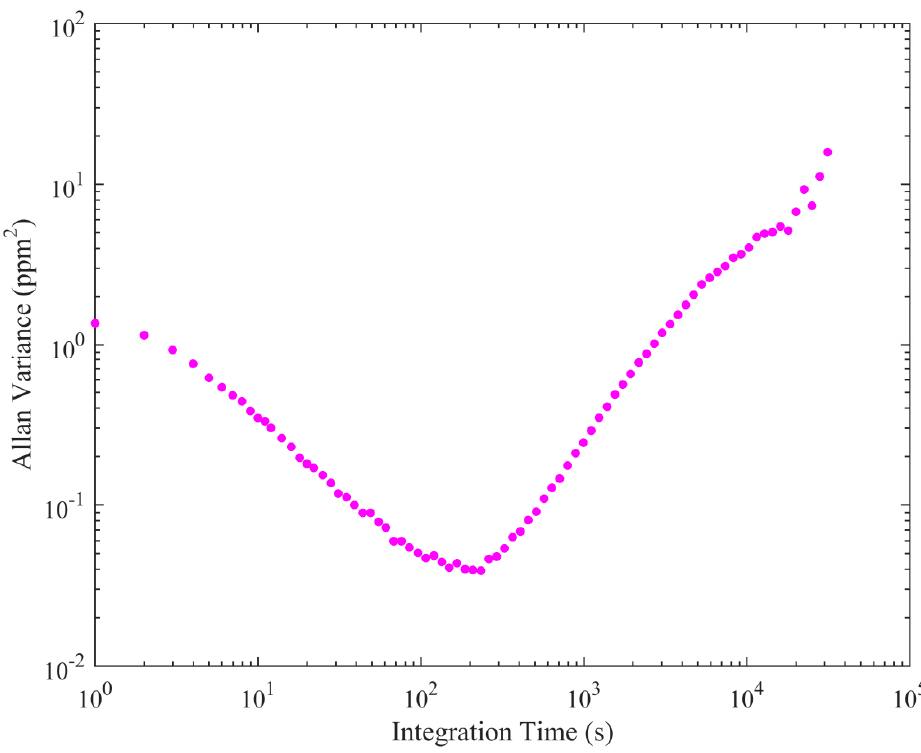
Figure 5. The Allan variance (magenta dots) plotted against integration time on a logarithmic scale.